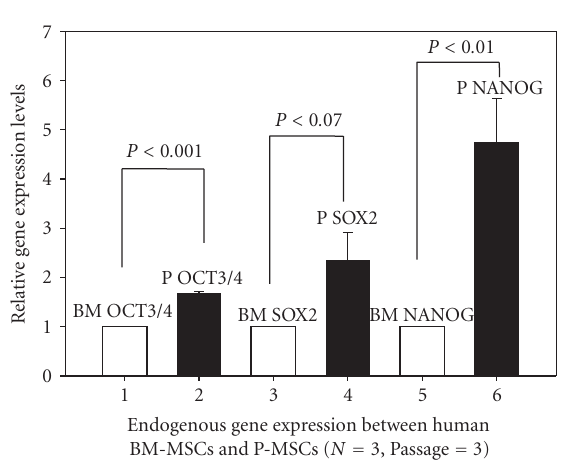
Figure 4: Comparative analysis of pluripotency associated endoge- nous gene expression between human marrow derived MSC and human placenta-derived MSC. Oct4. Sox2, and nanog gene expression profiles of bone-marrow-derived MSC and PDMSC analyzed by real-time qPCR analysis; error bars represent SE in five separate